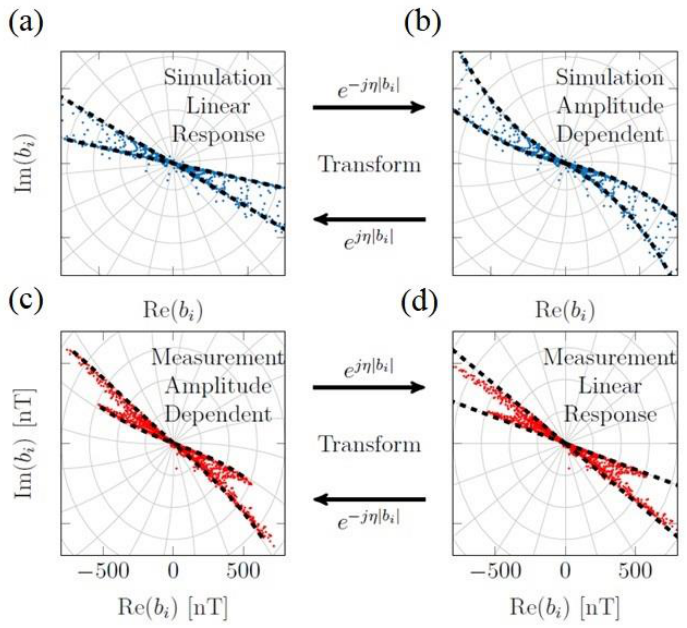
Figure 5. The real and imaginary parts of ( a , b ) simulated result and ( c , d ). Experimental measured magnetic field response for CT100 and ARA100 MNP types.